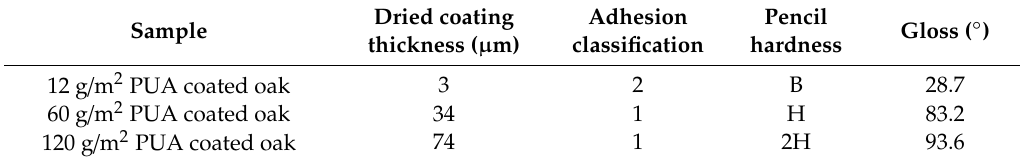
Table 4. Adhesion, hardness, and gloss of oak coated at di ff erent coating amounts.